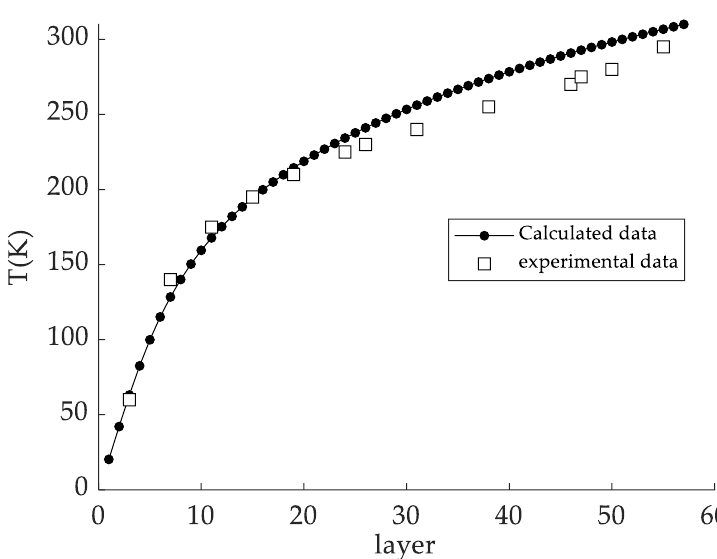
Figure 4. Comparison between calculated and experimental data.